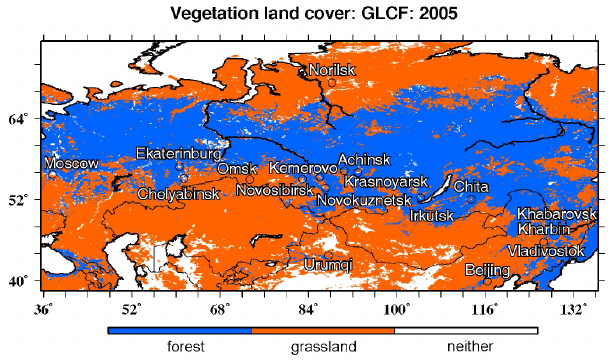
Figure 1. Spatial distributions of the two vegetation land-cover aggregated categories considered in this study: forest (blue), and grassland including agricultural land (red). The pixels where a dom- inant category is neither forest nor grassland are left blank. The plots are based on GLCF (2005) data re-gridded with a resolution of 0 . 2 ◦ × 0 . 1 ◦